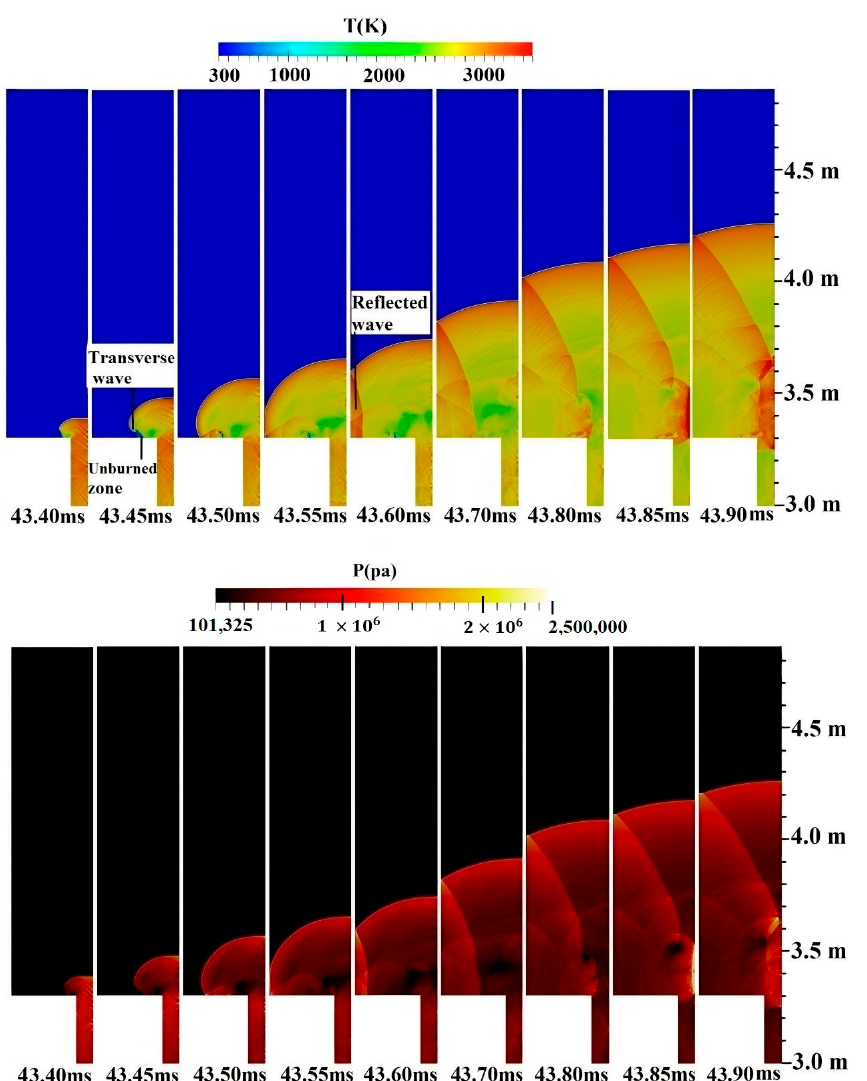
Figure 9. Temperature and pressure contours for the propagation of the flame in H 2 –air mixture 20% hydrogen with 20% hydrogen concentration .